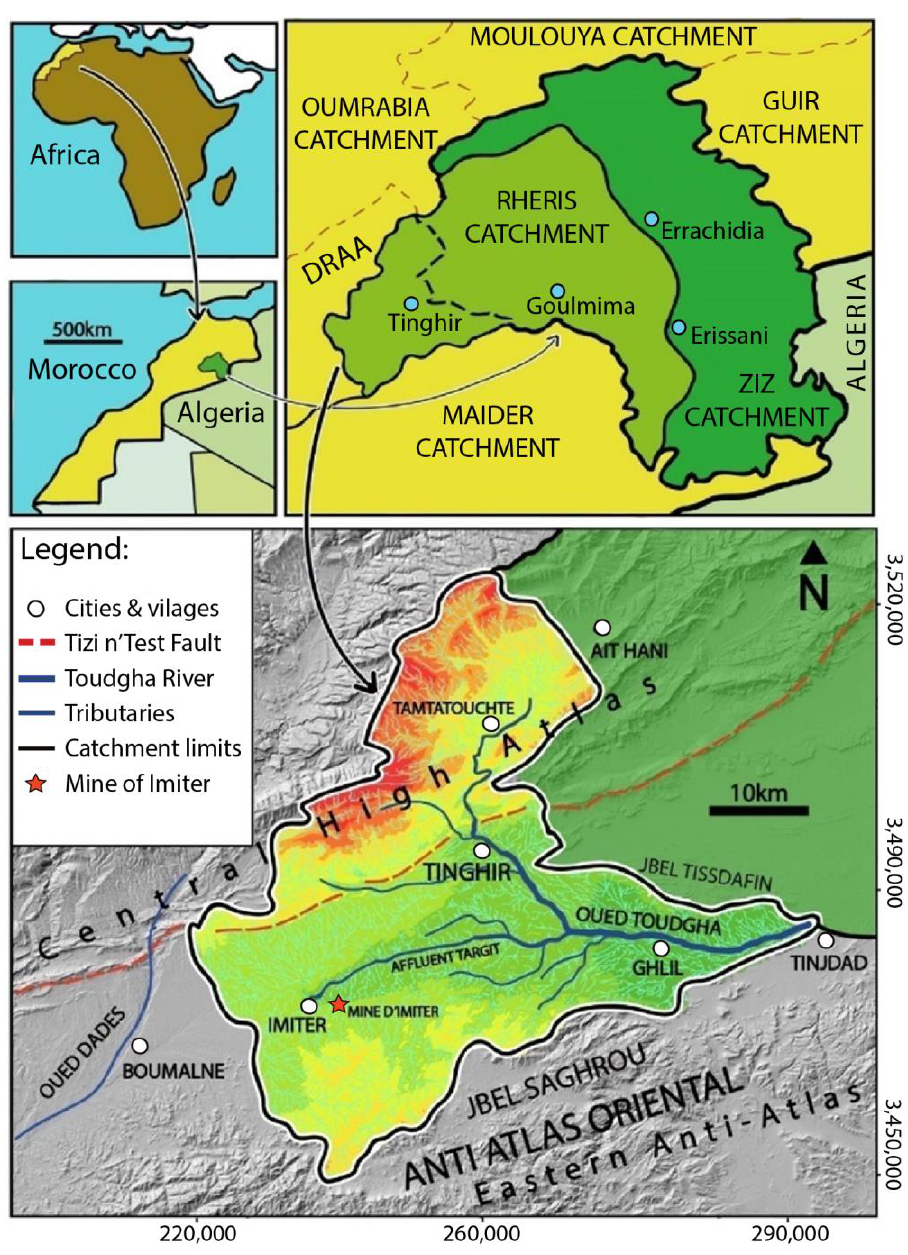
Figure 1. The geographical location of the Toudgha River watershed.